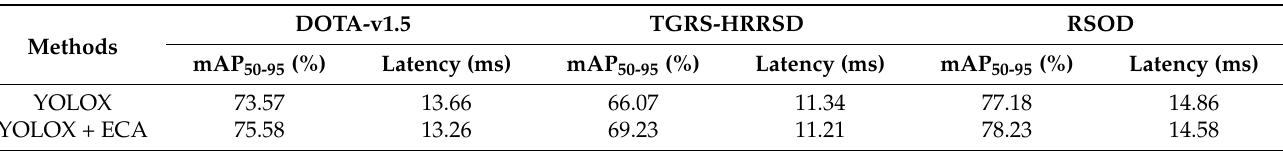
Table 2. Effects of ECA on three datasets.